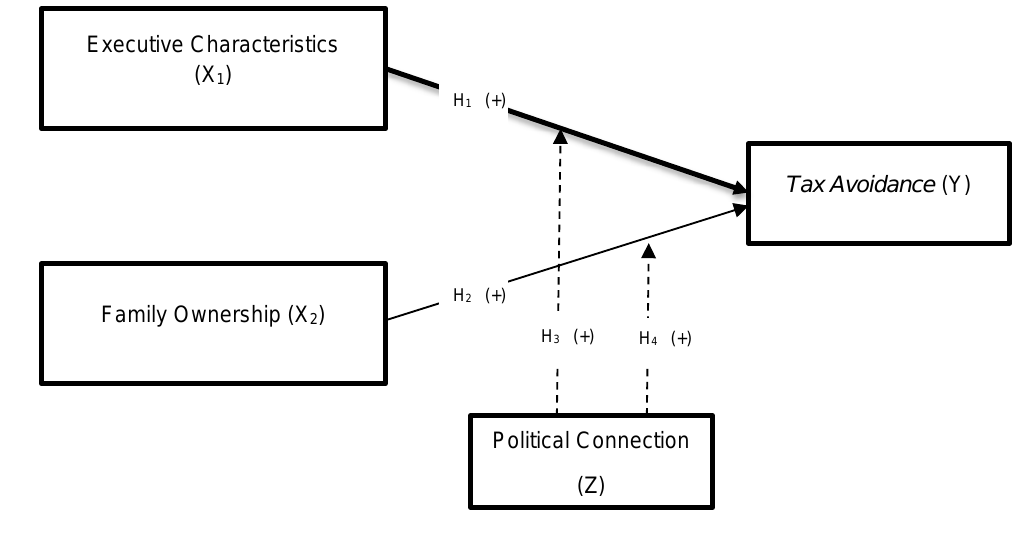
Figure 1: Research Conceptual Framework